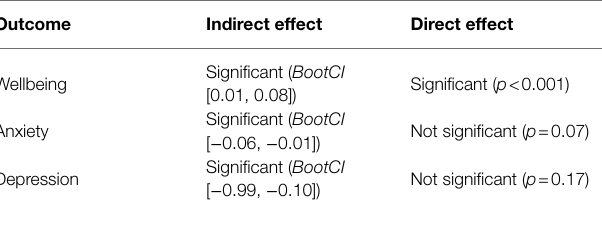
TABLE 2 | Summary of mediation analyses: Indirect and direct effects of gratitude on outcomes mediated by acceptance of illness.